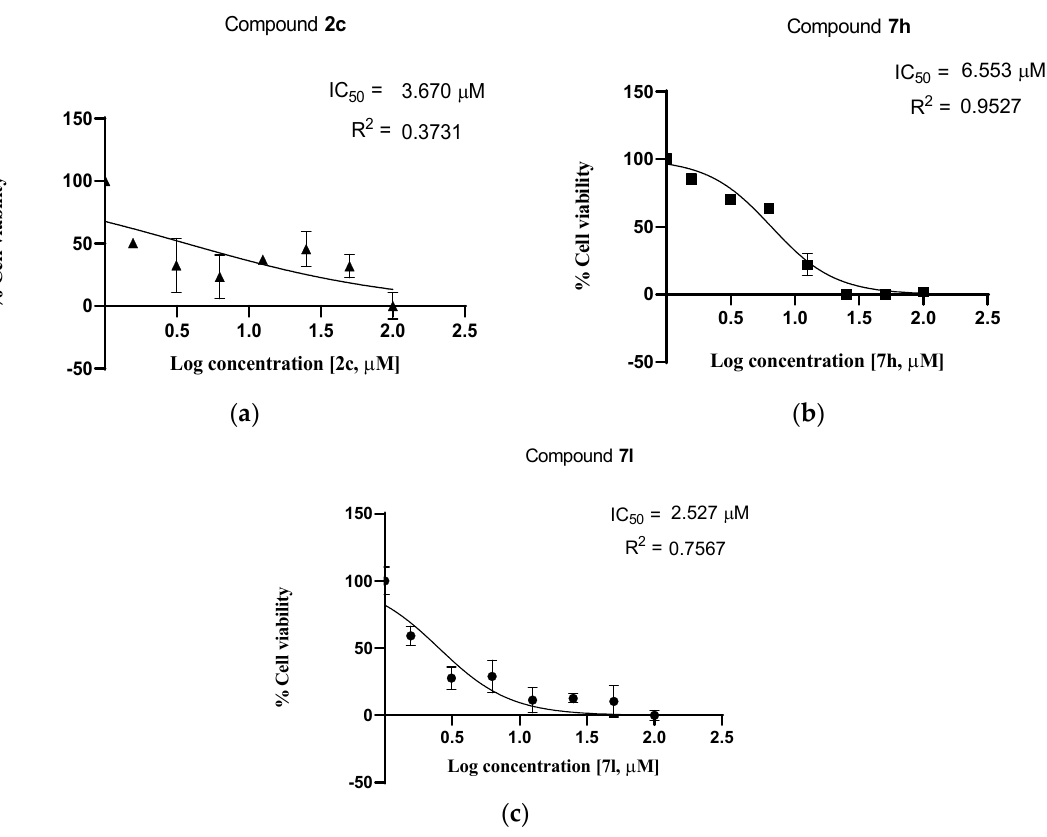
Figure 5. Dose response curves for the compounds in HCT116 cells after 72 h incubation. Similarly, Figure 6 represents the dose–response curves for the compounds 2c , 7h and 7l in HCT116 cells after 72 h incubation.